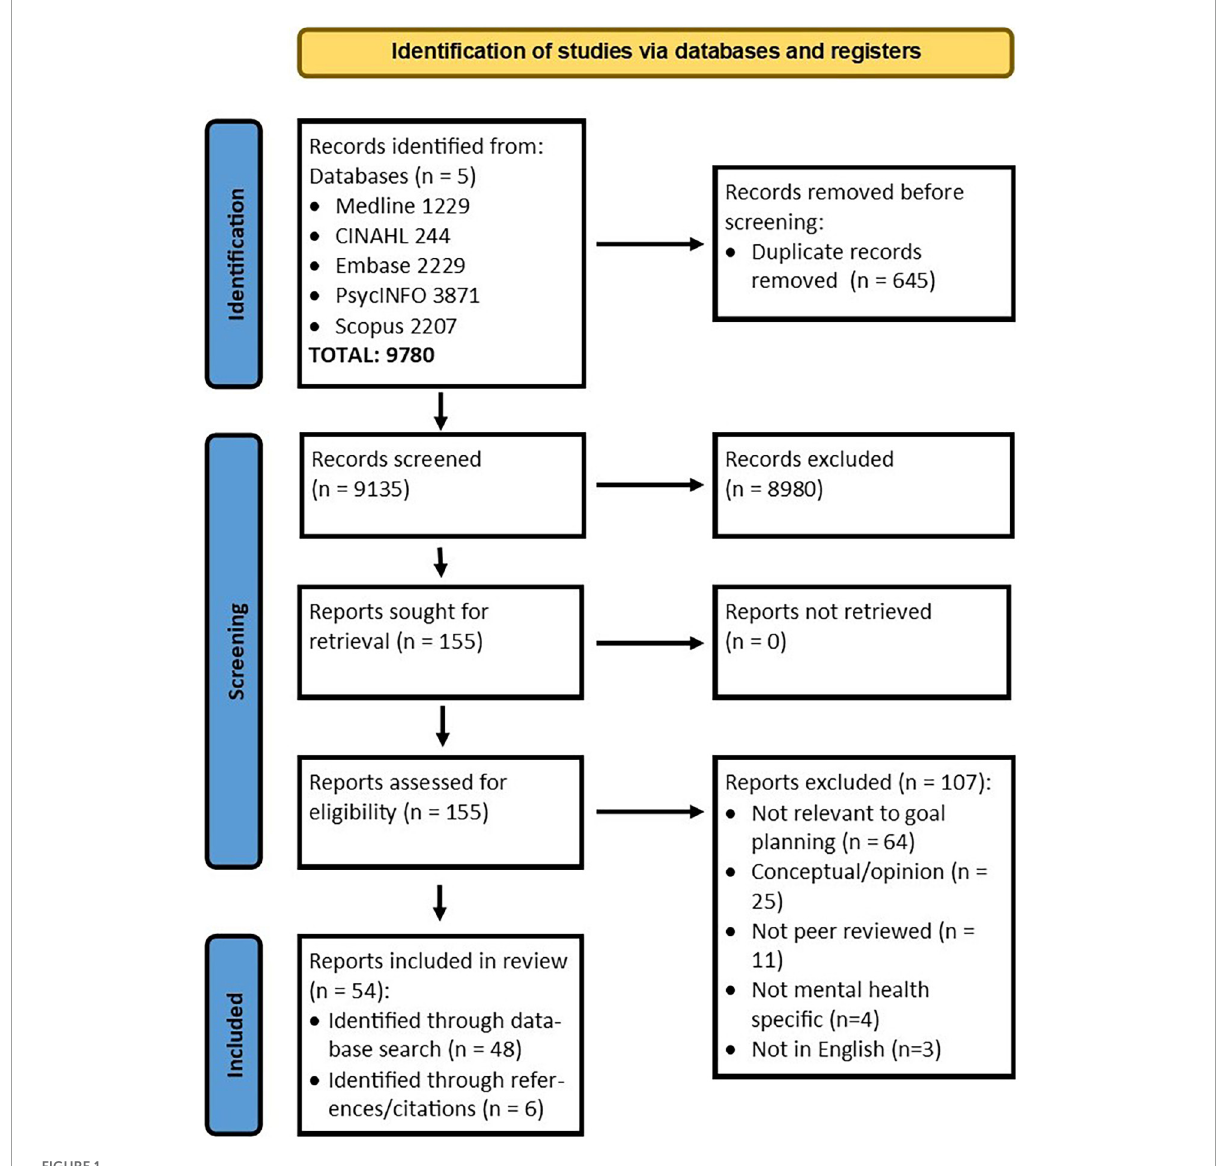
FIGURE1 PRISMA flow